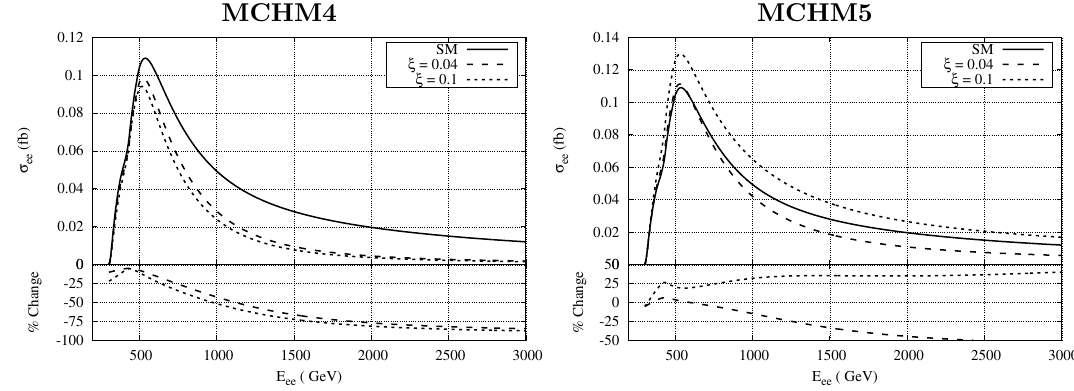
Figure 4 . e + e − → hh cross-section as a function of the electron-positron center of mass energy E ee in the MCHM4 (left panel) and MCHM5 (right panel) benchmarks.